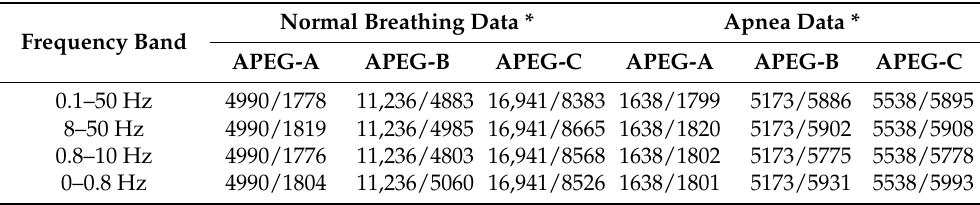
Table 1. General apnea group subject patterns for the proposed frequency